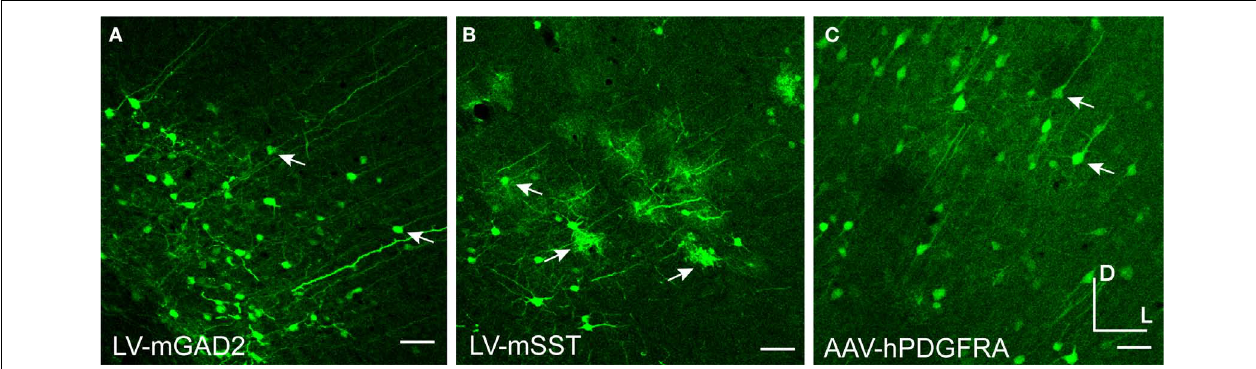
FIGURE 10 | Mammalian promoters drove expression in rodent cortex. Mice were injected with LV expressing GFP driven by mouse promoter sequences for glutamate decarboxylase 2 [LV-mGAD2 – (A) ] and somatostatin [LV-mSST – (B) ]. Rats were injected with AAV expressing GFP driven by the